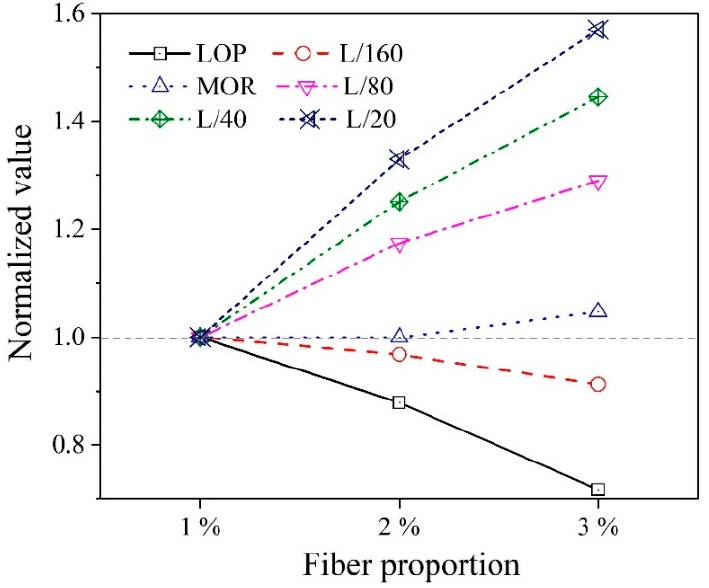
Figure 12. Normalized analysis based on the toughness of the 1% WFN fiber-reinforced concrete sample.